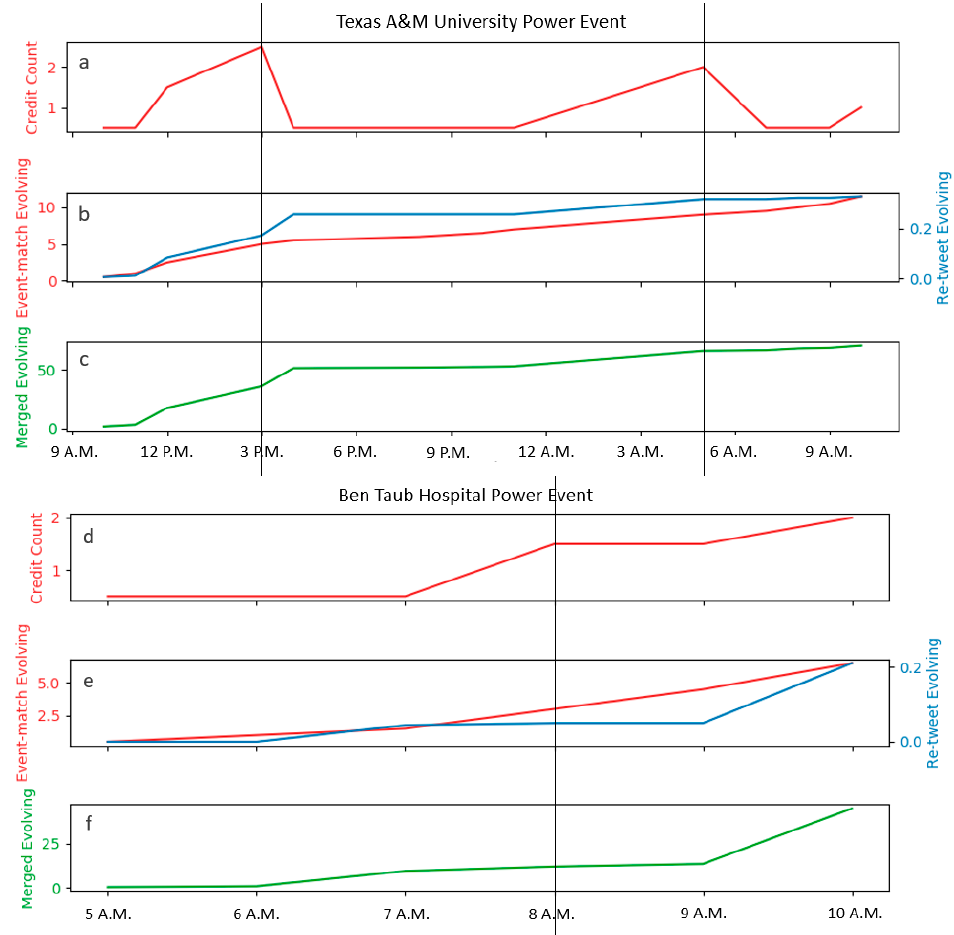
Figure 9. The evolving credibility under the Power theme for Texas A&M University (Panels a , b and c ) and Ben Taub Hospital (Panels d , e , and f ). Panels a and d are for credit count, panels b and e are for event-match evolving, and panels c and f are for merged evolving.